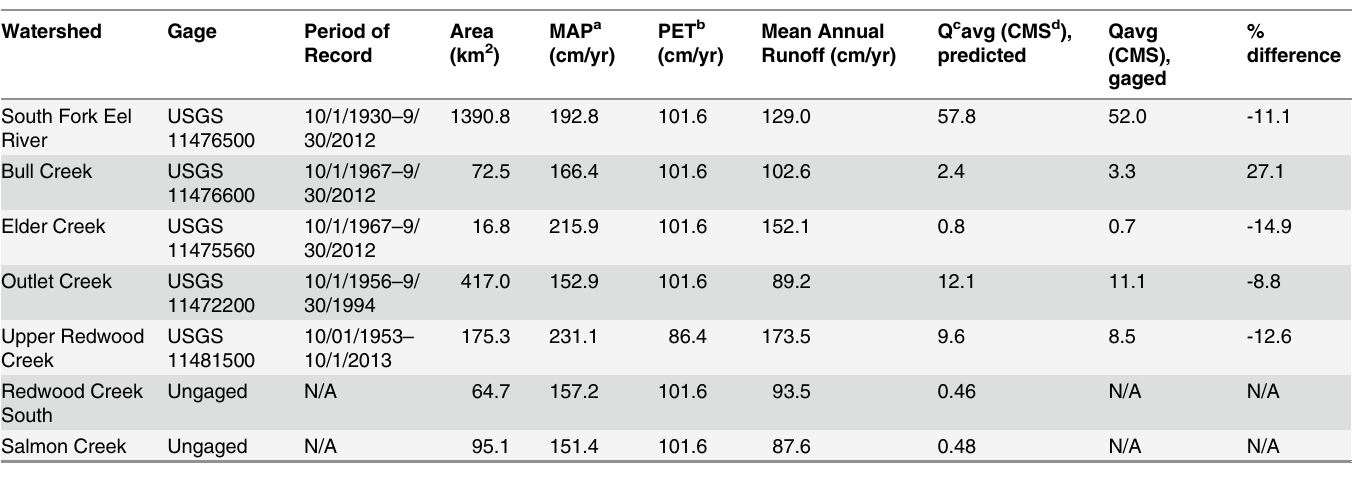
Table 1. USGS stream gages in or near study watersheds.